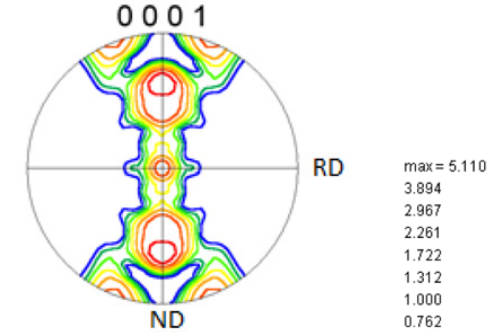
Fig. 1. Pole figure of initial texture of ZEK100 sheet.